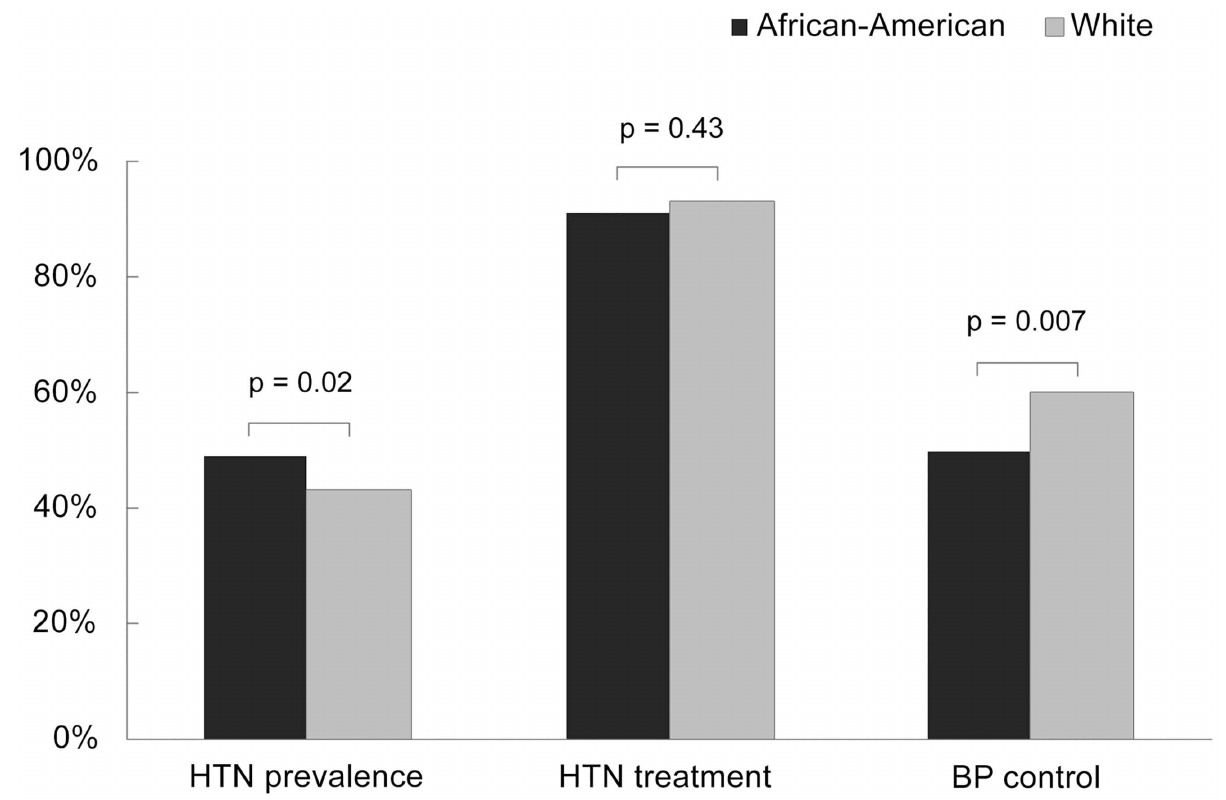
Fig 2. Prevalence, treatment, and control of hypertension stratified by race among HIV-infected patients attending the UAB 1917 HIV Clinic in 2013.